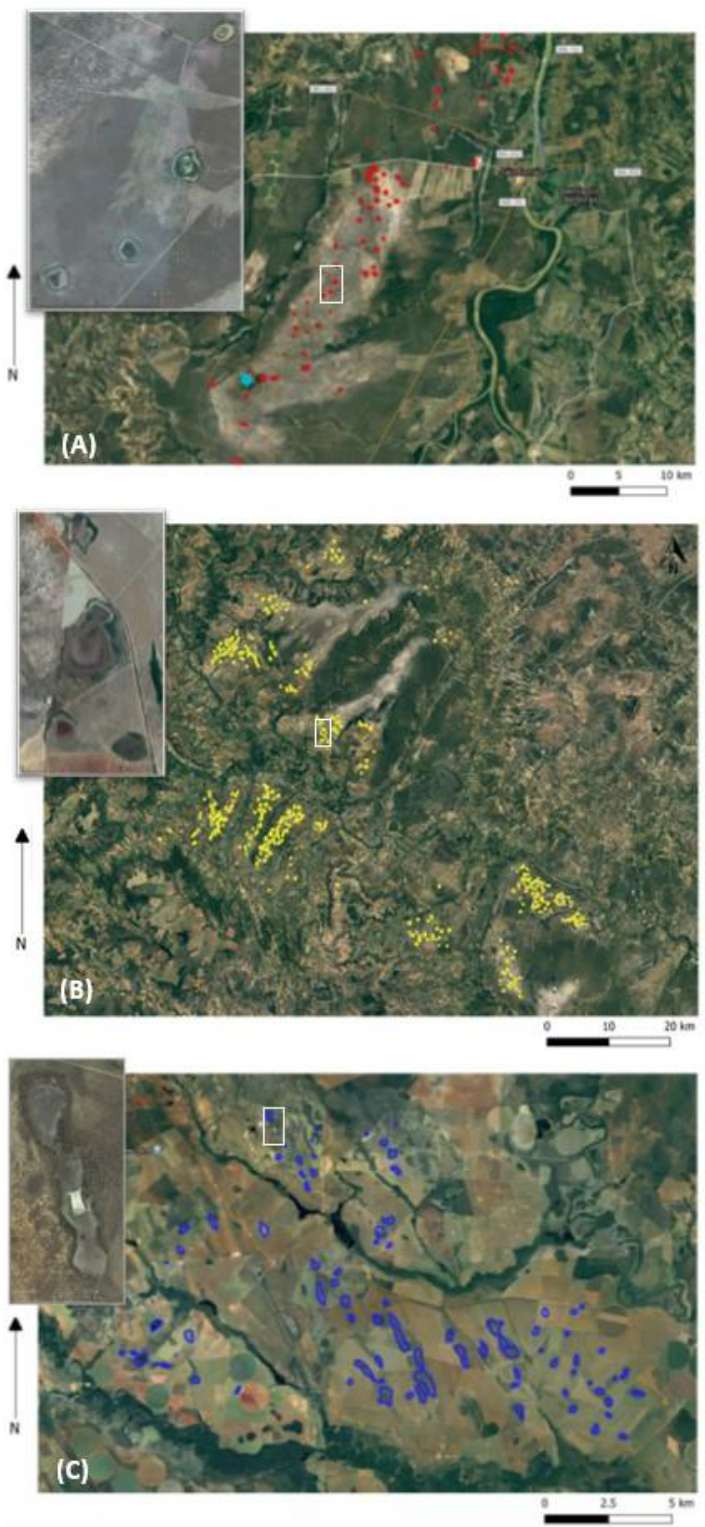
Figure 3. Mapping of the fairy circles in the 3 studied zones in the São Francisco Basin (see location Figures 1 and 2). ( A ): zone Brazil_1; ( B ) zone Brazil_2; ( C ) zone Brazil_3. Insert is a zoom on one of these depressions located by the rectangle on the large image. The second zone, Brazil_2, where the structures have been mapped in yellow is lo- cated at about 35 km NW of the previous one with 406 structures mapped in this 321 km 2